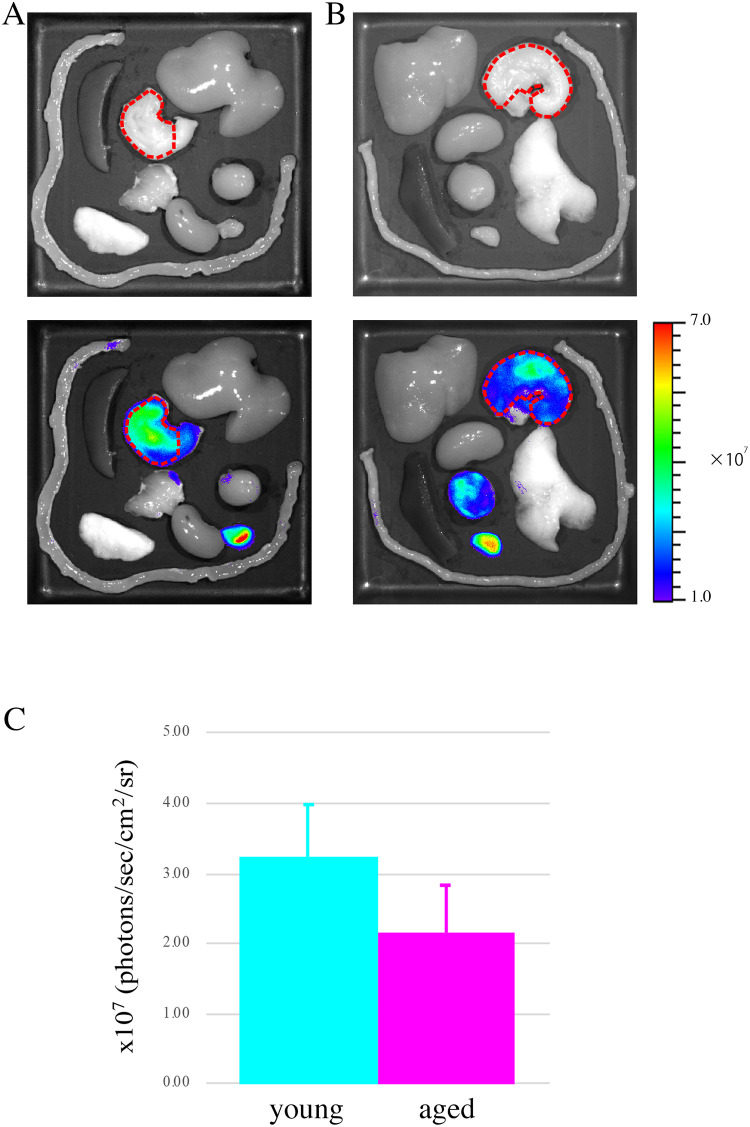
Ex vivo bioluminescence imaging of rNG2-fLuc Tg rats.(A-B) Bioluminescence images of several organs removed from young (A) and aged (B) Tg rats. The area indicated by red dashed lines includes the stomach and shows regions of interest (ROI). Upper panels: Photographs of several organs. Lower panels: Bioluminescence images of these organs. (C) Quantification of bioluminescence signals from the isolated stomach of young (light blue bar, n = 8) and aged (pink bar, n = 8) Tg rats.